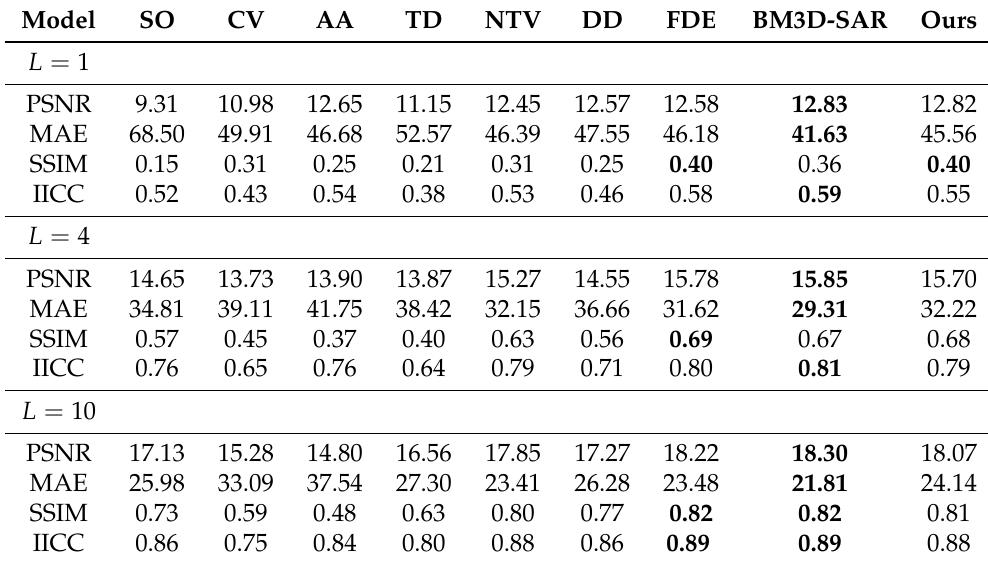
Table 3. Quantitative comparison of the different models for the texture1 image.